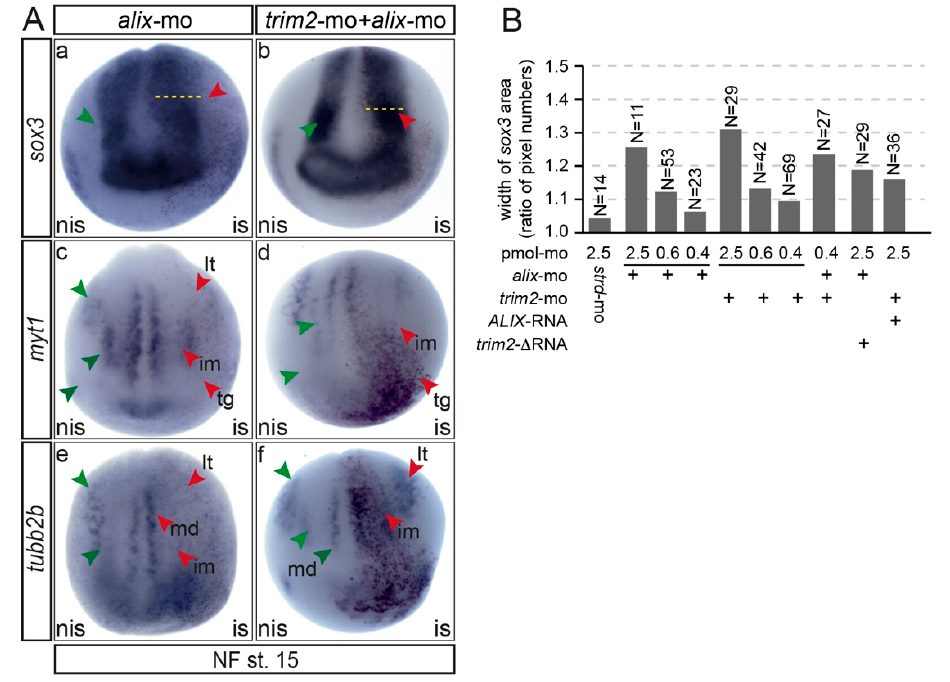
Figure 7. trim2 and alix act in parallel on the formation of primary neurons in Xenopus . ( A ) A comparison of early neuronal marker gene ( sox3 , myt1 , and tubb2b ) expression at NF stage 15 of trim2 , alix, and combined morphants revealed that primary neurogenesis is likewise impaired. (a–c) An apparent, widened expression of sox3 -positive neural progenitors in the neural plate region on the injected side (red arrowheads and dotted lines). (d–i) The expression of the neural specification marker myt1 and the di ff erentiation marker tubb2b were repressed or lost upon the suppression of trim2 , alix , and trim2 / alix function. Primary neurons revealed as medial (md), intermediate (im), longitudinal (lt) stripes, and trigeminal placode (tg) ( myt1 and tubb2b positive cells). Figure 7a,b: strd-mo, n = 10E; co-inj. trim2 / alix -mo, n = 20E; p = 9.47E-06, unpaired χ 2 test, χ 2 = 19.6, df = 1, po = 17, p < 0.001; Figure 7c,d: myt1 : strd-mo n = 10E; trim2 / alix -mo n = 12E; p = 1.85E-05, χ 2 = 18, df = 1, po = 11; Figure 7c,d: tubb2b : strd-mo , n = 10E; trim2 / alix -mo , n = 13E; p = 1.12E-05, unpaired χ 2 test, χ 2 = 19, df = 1, po = 12, p < 0.001). ( B ) E ff ect of combined injection of low doses of trim2 and alix mo. To determine the dose of morpholino injection that caused only a very mild phenotype compared to standard morpholino-injected embryos, decreasing amounts of trim2 -mo or alix -mo were injected into one cell of a two-cell stage embryo. The width of the sox3 expression domain was measured using ImageJ, and the ratio between the non-injected and the injected side was calculated. Combined injection of 0.4 pmol of trim2 and alix -mo each led to an additive e ff ect compared to individual injections (0.4 pmol trim2 -mo + 0.4 pmol alix -mo). The trim2 morpholino phenotype could not be rescued by co-injection with either h alix -RNA (1ng) n = 36E, and the alix -morpholino phenotype could not be rescued by ∆ trim-2 RNA (1ng) n = 29E.